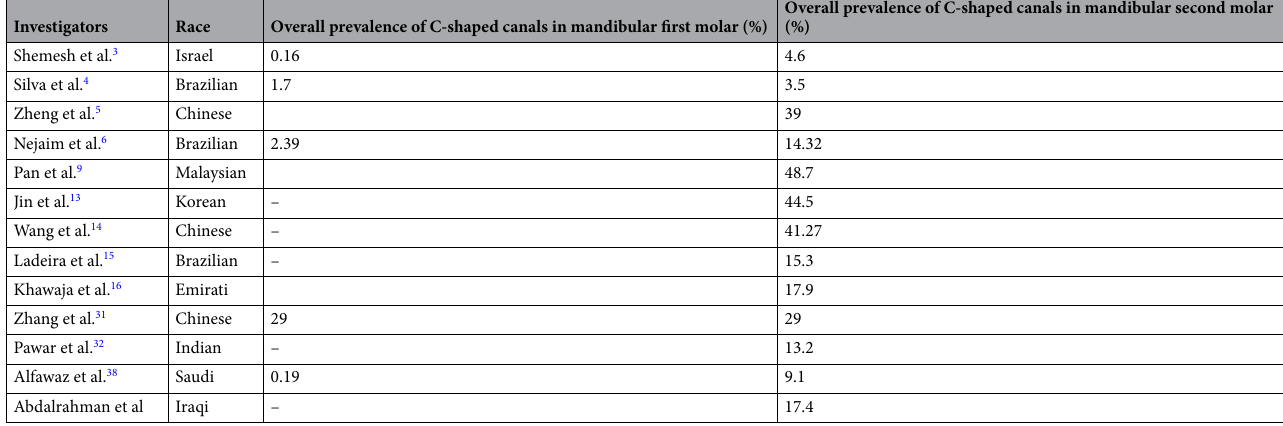
Table 4. Incidence of C-shaped root canal configuration mentioned by in vivo